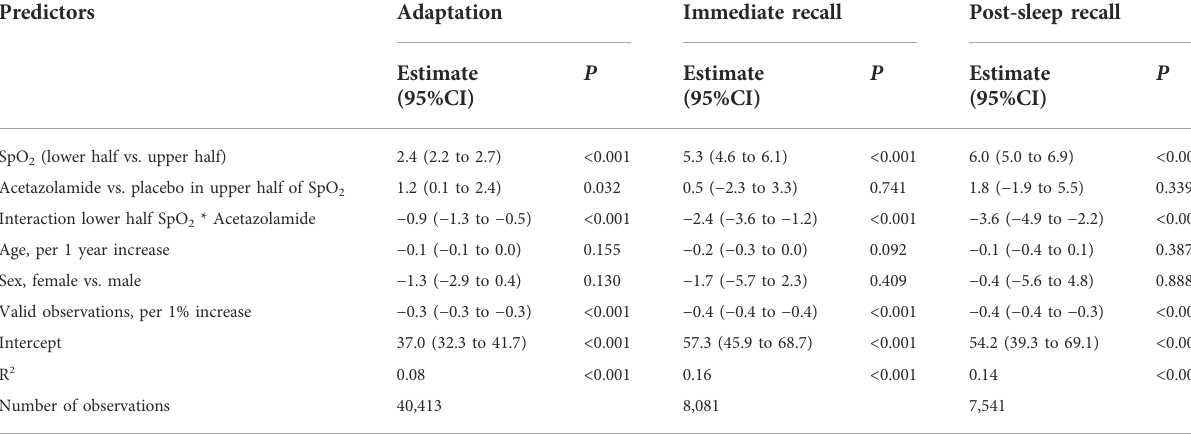
Paneldatamultivariatelinearregressionmodelwithpatientnumberde fi nedaspanelvariableandmovementnumberastimevariable;CIdenotescon fi denceinterval;SpO 2 ,pulseoximetry. SpO 2 , drug group and sex are binary variables. A positive value indicates an increase in directional error